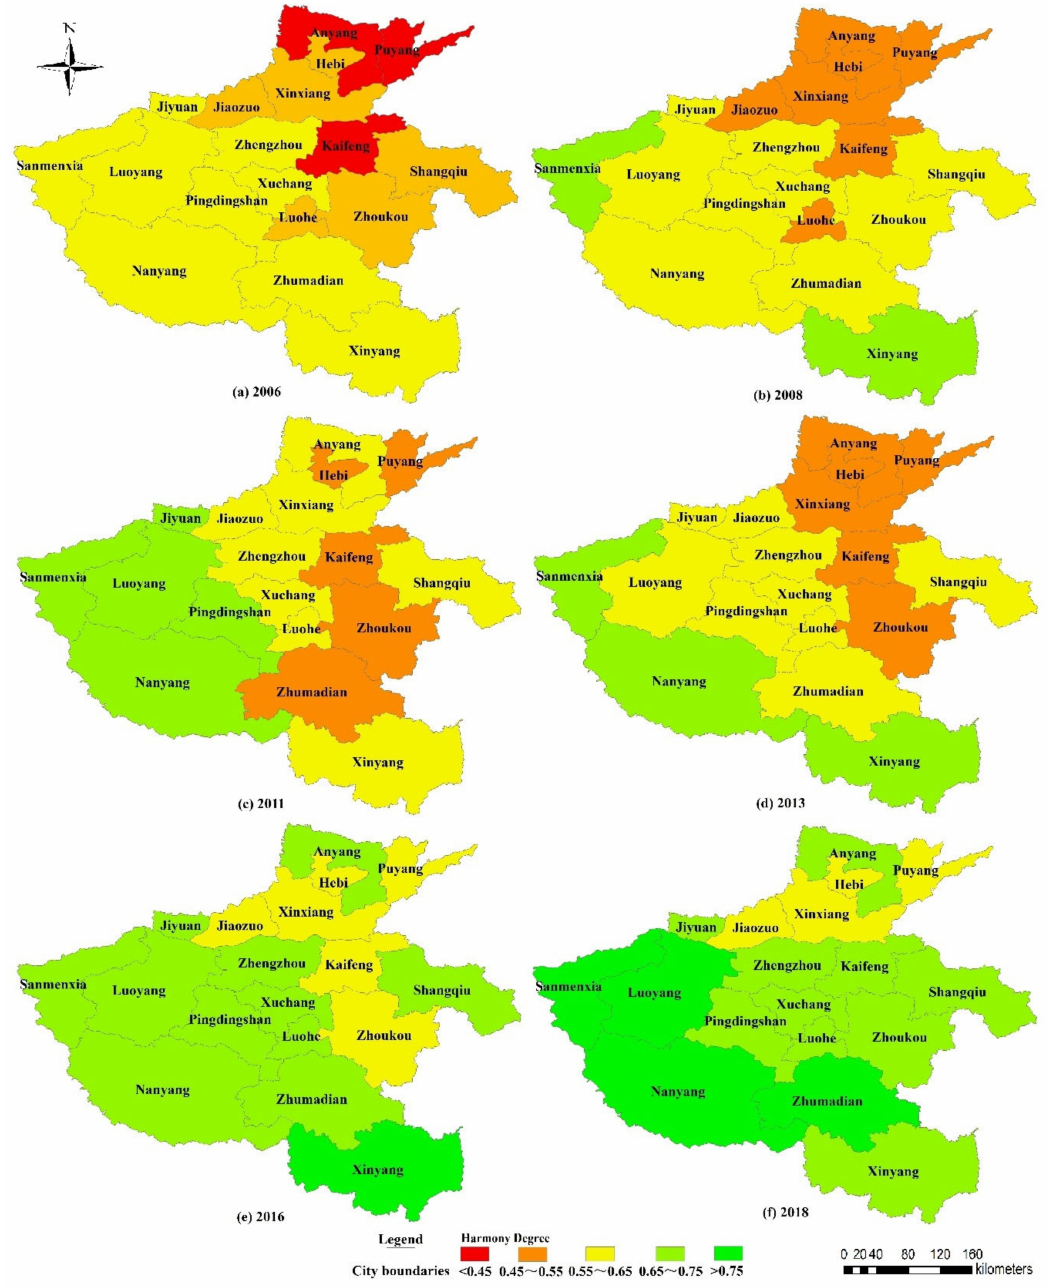
Figure 4. Spatial variation of human-water harmony degrees in Henan Province from 2006 to 2018. In 2006, among the 18 cities in Henan Province, there are three cities with a human- water harmony degree lower than 0.45 (red area in the figure), namely Puyang, Anyang, and Kaifeng. This may be caused by the low precipitation in these regions, leading to serious water shortage. According to the Henan Provincial Water Resources Bulletin in 2006, the precipitation was low in these regions. Among them, Puyang has the